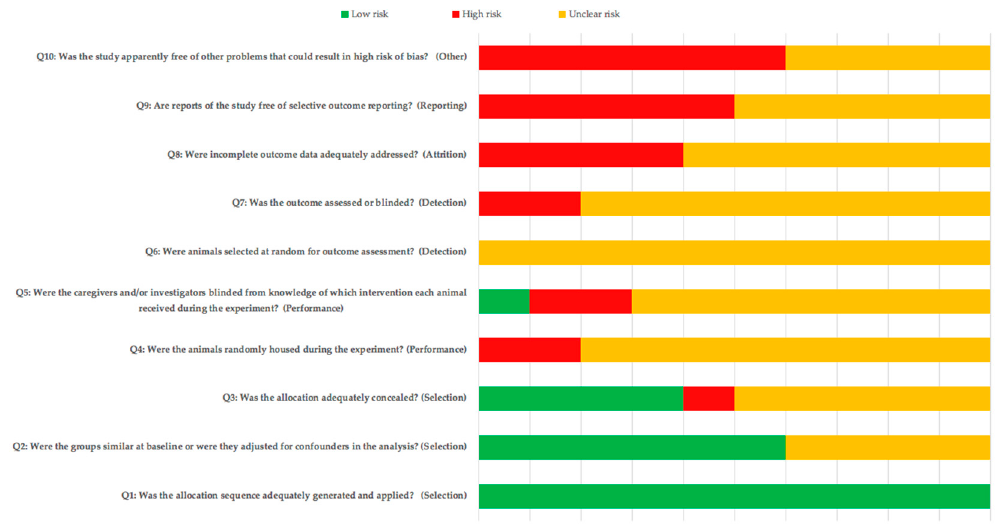
Figure 2. SYRCLE's risk of bias tool. Figure 2. SYRCLE’s risk of bias